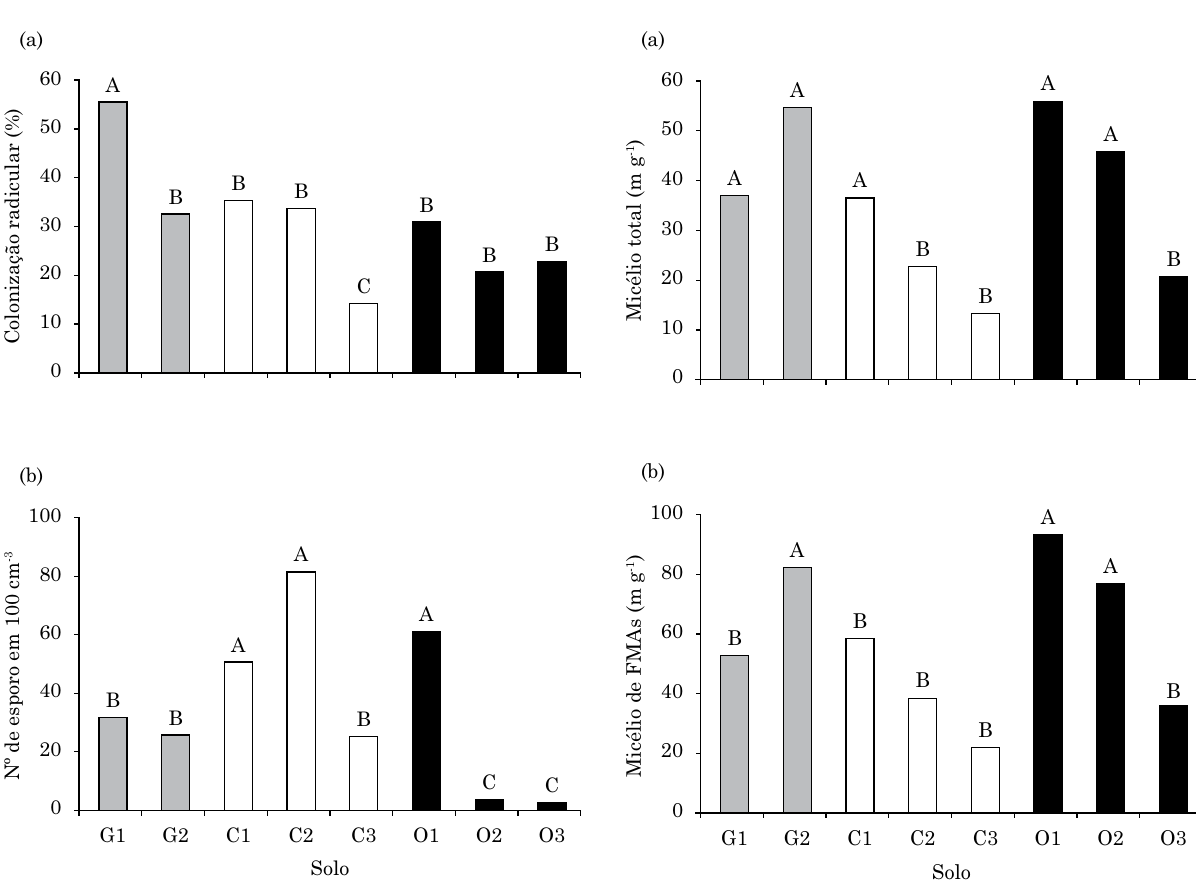
Figura 1. Porcentagem de colonização micorrízica de Brachiaria brizantha no bioensaio do potencial de inóculo micorrízico (a) e número de esporos de fungos micorrízicos arbusculares (b) em áreas amostradas de Gleissolos (G1-G2), Cambissolos (C1 a C3) e Organossolos (O1 a O3). Barras seguidas pelas mesmas letras não diferem significativamente (p<0,05) pelo teste de Scott-Knott.